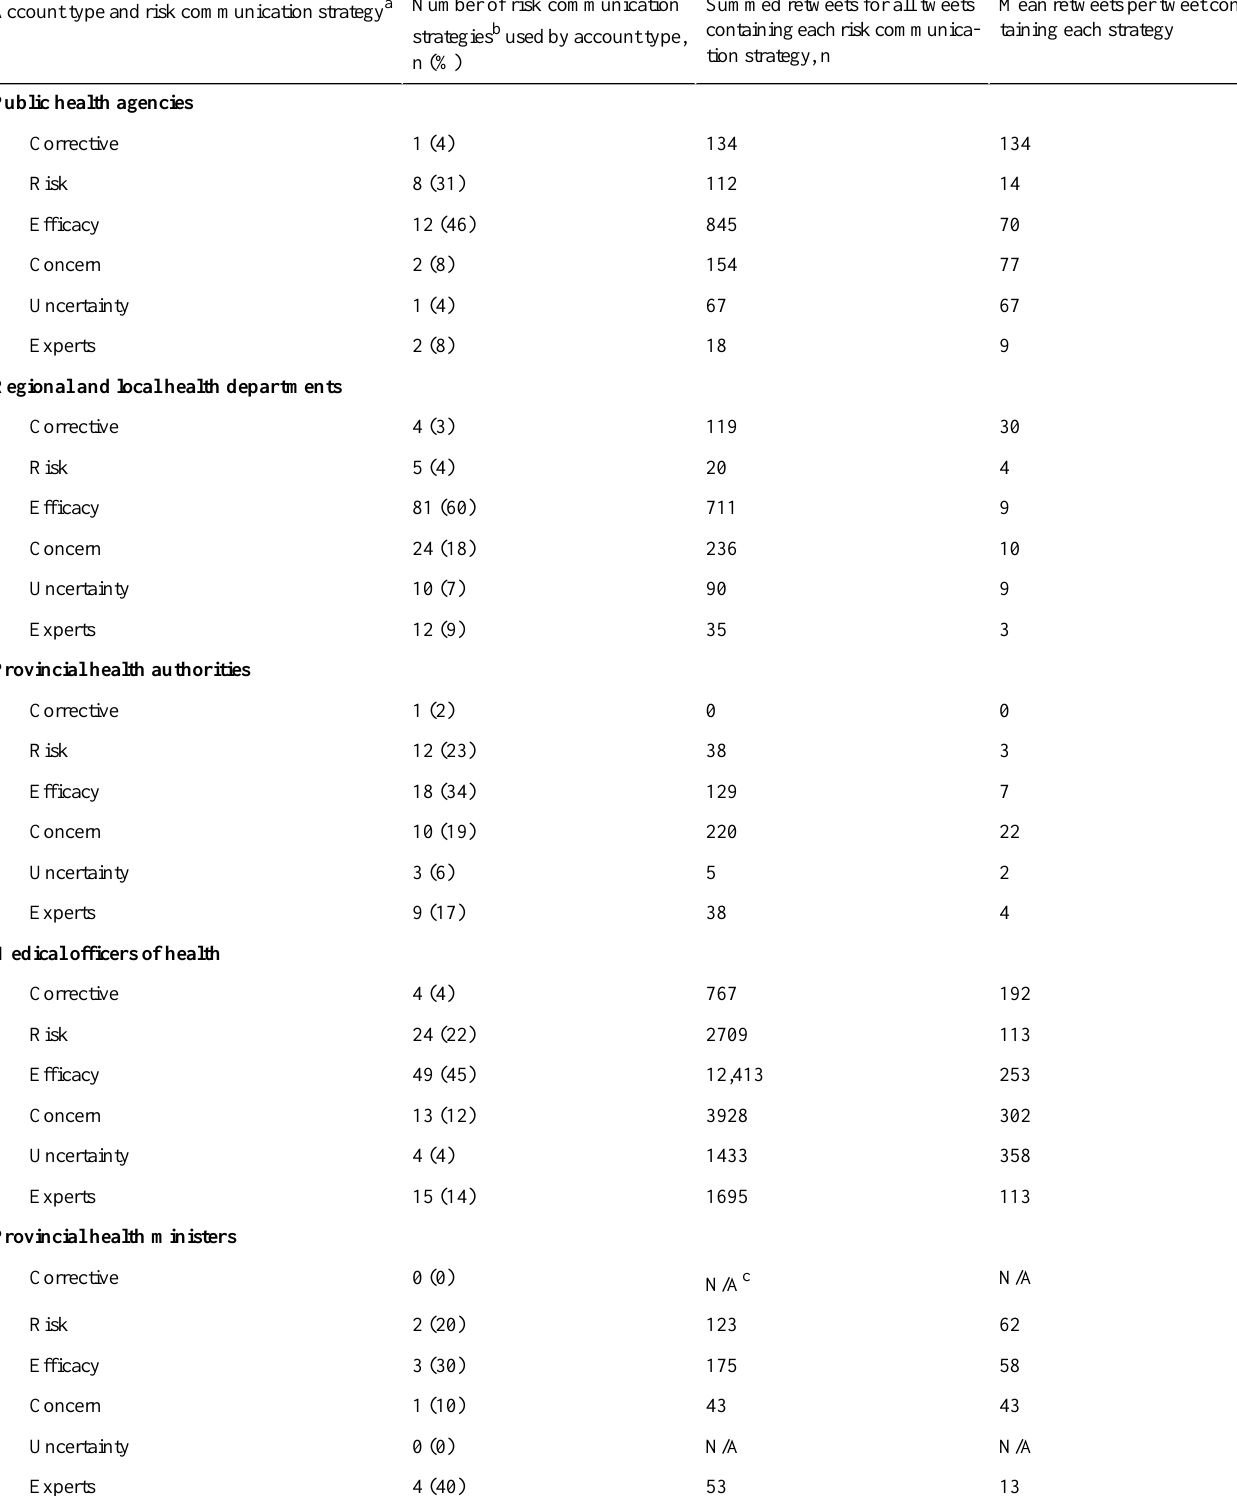
Table 4. Summed risk communication strategies (n=334) and percentages and retweet frequencies by strategy and account type, January 1, 2020,